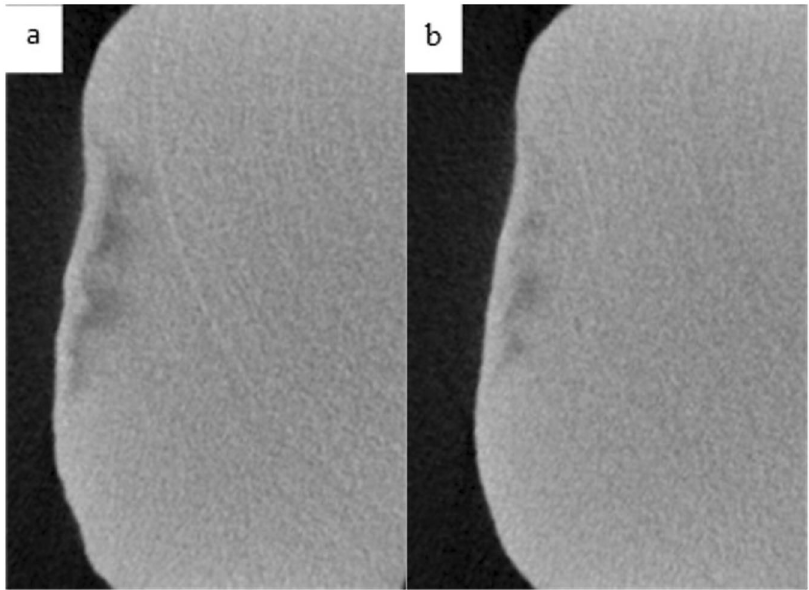
Fig. 2 Remineralization of etched enamel MIH lesions with 20% hydroxyapatite toothpaste. Representative µ-CT images of etched enamel MIH lesions, before ( a ) and after ( b ) in-situ remineralization.